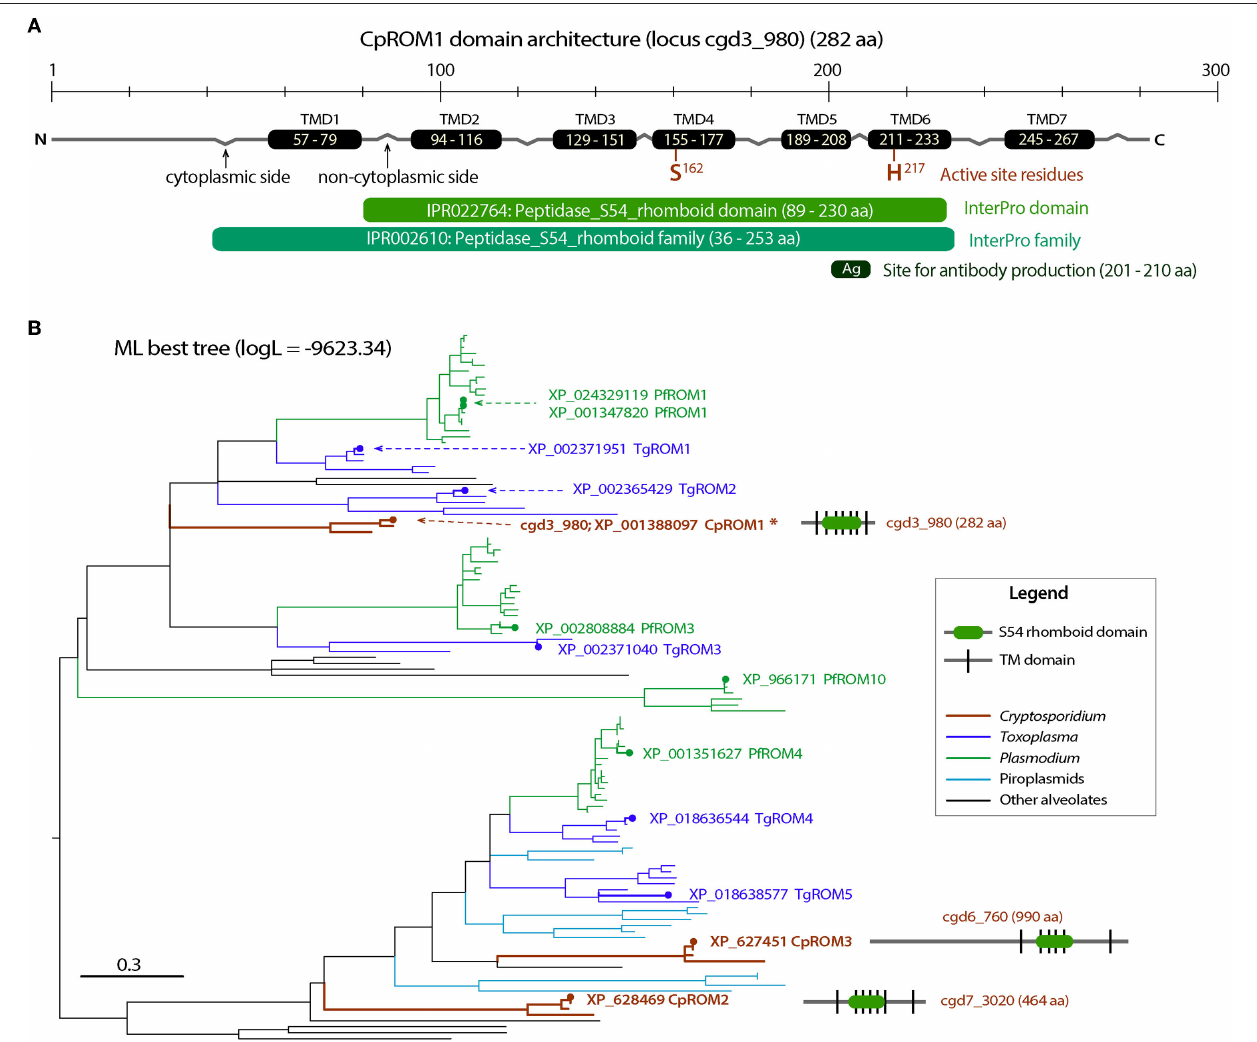
FIGURE 4 | Molecular and phylogenetic features of CpROM1 (cgd3_980). (A) Architecture of CpROM1 (282 aa), showing seven transmembrane domains (TMDs), two active site residues (S 162 and H 217 ) in TMD4 and TMD6, regions homologous to specified InterPro domain and family, and the site which was used to design the short peptide used for antibody production. Small zigzags indicate the positions of inter-TMD regions (cytoplasmic vs. non-cytoplasmic sides of the membrane). The lengths of domains are scaled. (B) A maximum likelihood (ML) tree (log L = − 9,623.34) showing the relationship between the three CpROM proteins and orthologs in other major apicomplexan groups. Branches representing CpROM1 (cgd3_980; marked with an asterisk), CpROM2 (cgd7_3020) and CpROM3 (cgd6_760) are annotated with gene names, GenBank accession numbers, and domain organizations. Branches representing orthologs from Toxoplasma gondii (TgROMs) and Plasmodium falciparum (PfROMs) are indicated with GenBank accession numbers and names for